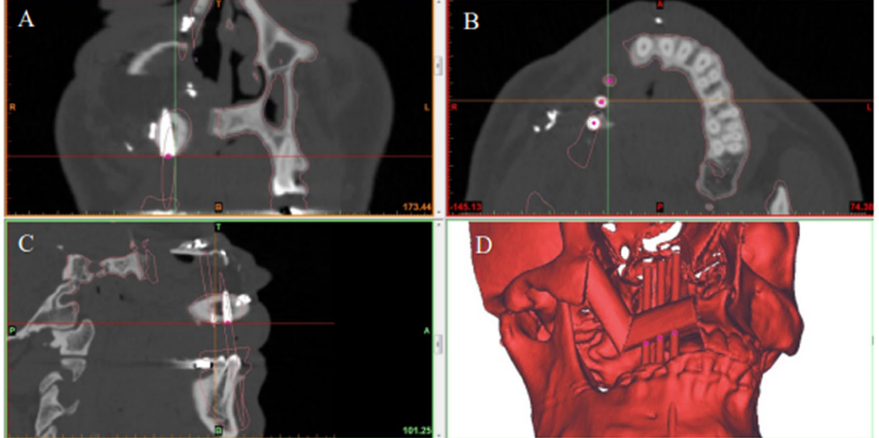
Figure 5. Preoperative CT scan showing virtual planned placement of dental implants in the recon- structed jaw in the ( A ) coronal, ( B ) axial, and ( C ) sagittal planes. ( D ) 3D model showing the final jaw reconstruction with implants in the ideal position according to virtual surgical plan.